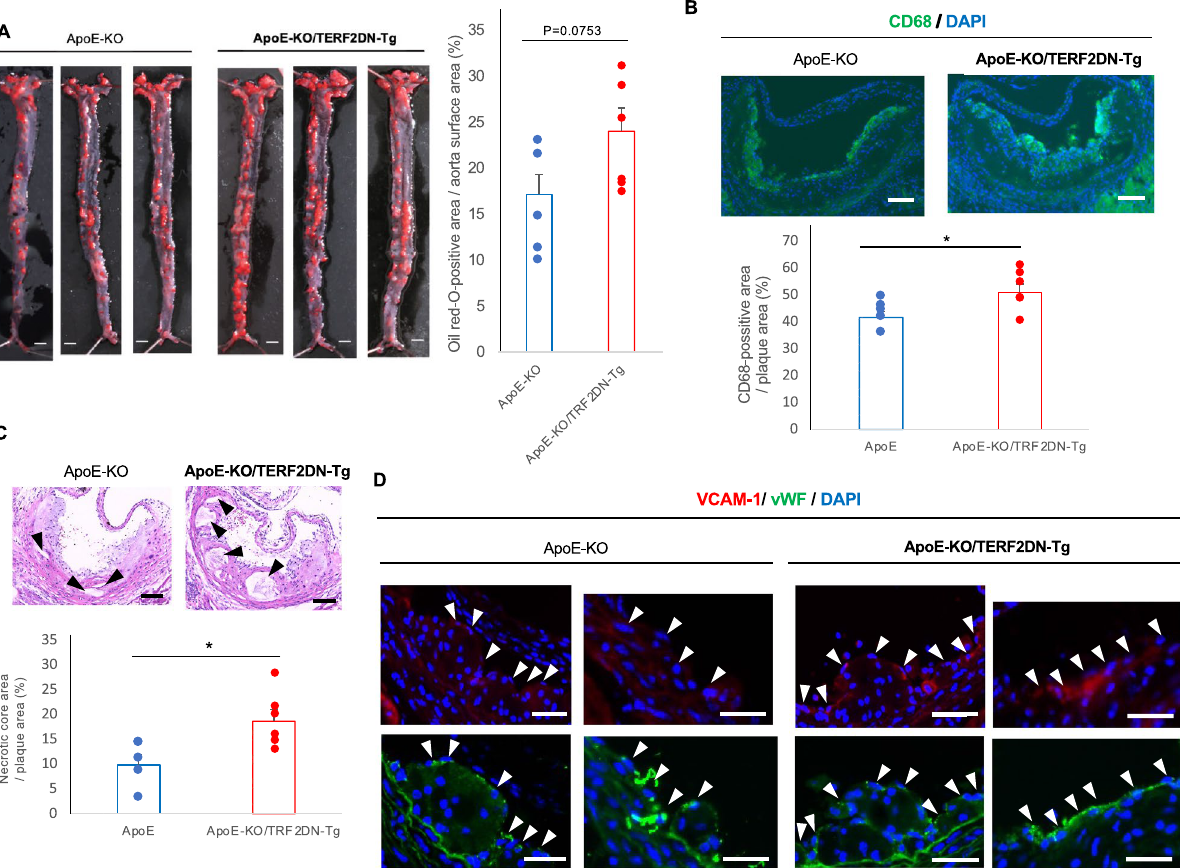
Figure 6. EC senescence affects the plaque characteristics. ( A ) En face analysis of the aorta in ApoE-KO and ApoE-KO/VEcad-TERF2DN-Tg mice fed a HCD for 8 weeks. Atherosclerotic plaques were quantitatively analyzed (n = 5 for ApoE-KO; n = 6 for ApoE-KO/TERF2DN-Tg). Bars: 1 mm. ( B ) Immunohistochemistry for CD68 in aortic sinus sections of ApoE-KO and ApoE-KO/VEcad-TERF2DN-Tg mice fed a HCD for 8 weeks. CD68-positive areas were quantified (n = 5 for ApoE-KO; n = 6 for ApoE-KO/TERF2DN-Tg). Bars: 100 μm. ( C ) H-E staining of aortic sinus sections of ApoE-KO and ApoE-KO/VEcad-TERF2DN-Tg mice fed a HCD for 8 weeks. Arrowheads indicate the necrotic core. The size of necrotic core was measured (n = 5 for ApoE-KO; n = 6 for ApoE-KO/TERF2DN-Tg). Bars: 100 μm. ( D ) Immunohistochemistry for VCAM-1 in aortic sinus sections of ApoE-KO and ApoE-KO/VEcad-TERF2DN-Tg mice fed a HCD for 2 weeks. Immunohistochemistry for vWF was performed using the serial sections to identify ECs. Arrowheads indicate the vWF-positive endothelium on the plaque surface. Bars: 100 μm. Data are presented as mean ± SEM. * p <